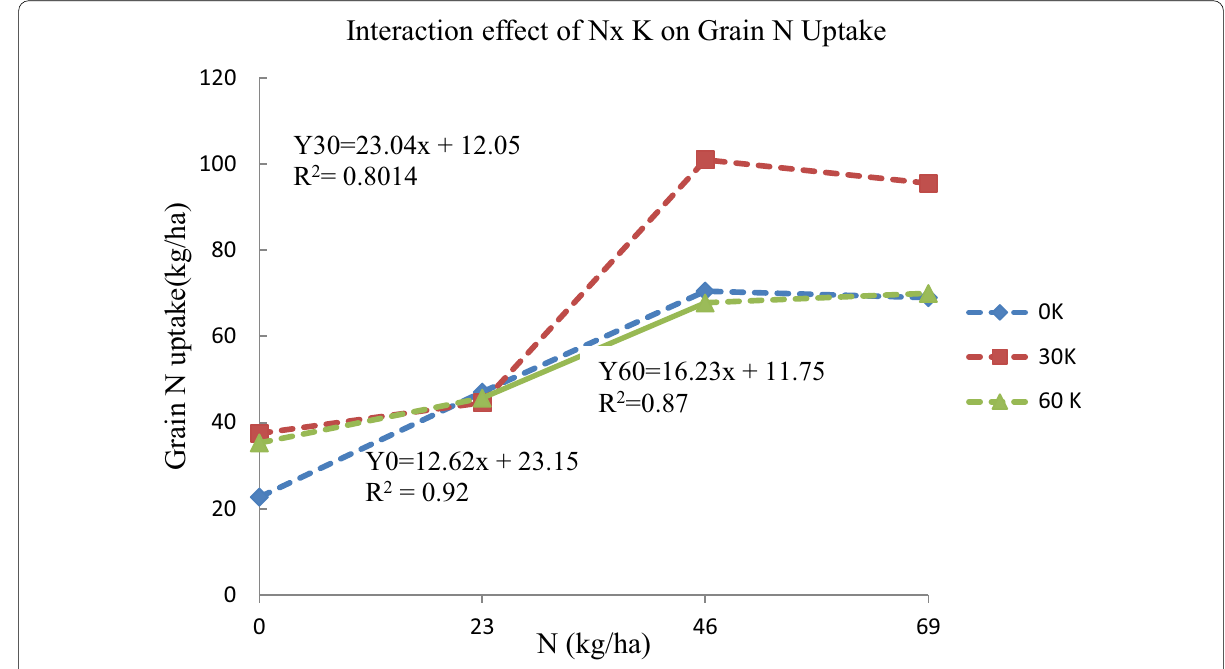
Fig. 4 Interaction effects of N and K on Grain N